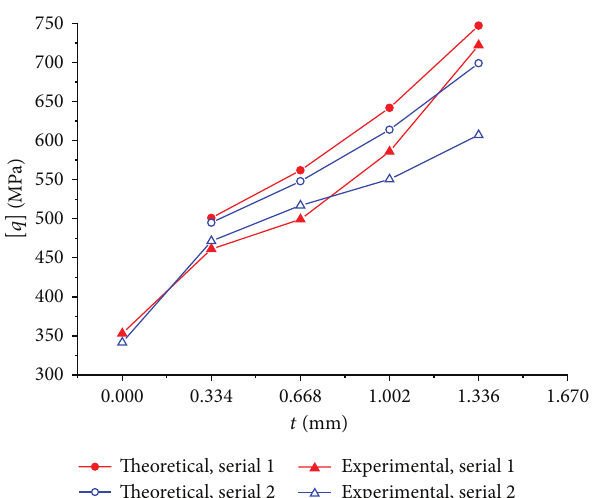
Figure9: [𝑞] - 𝑡 relationoftheCFRPsheetconfinedGFRPpipewhen 𝛽 are constants and 𝑅 𝑒 is 50 mm.